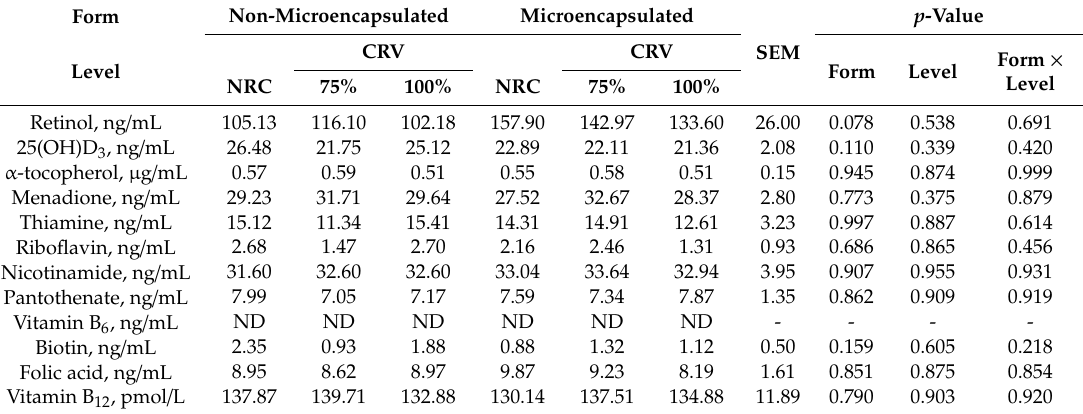
Table 6. E ff ects of vitamin forms and levels on plasma content of vitamins (d 0) 1